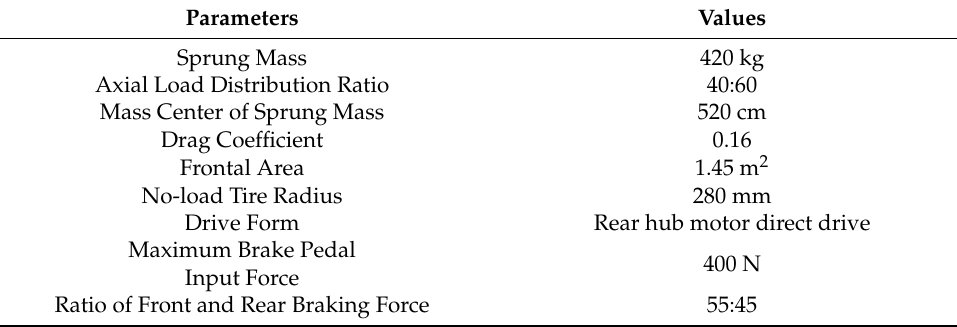
Table 2. Important parameter settings in